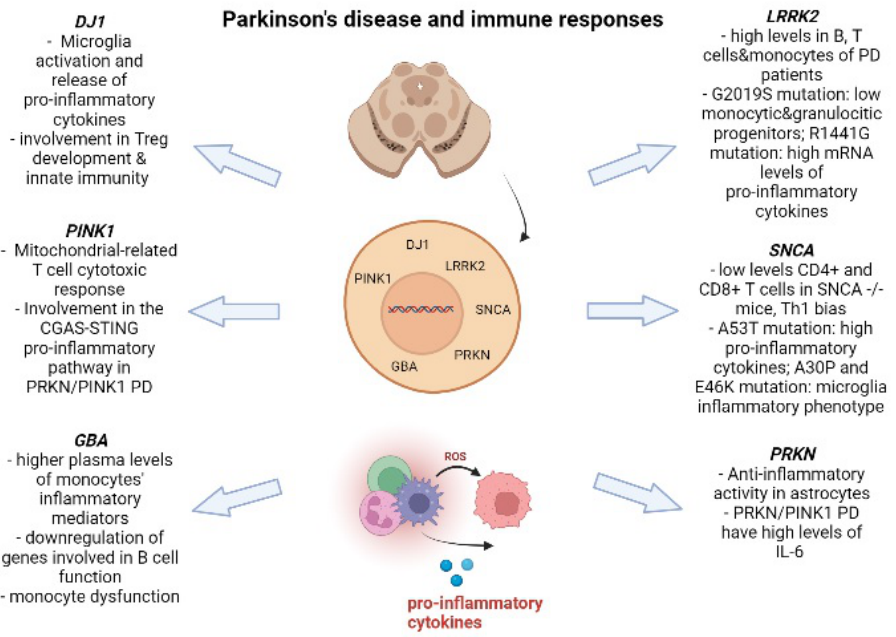
Figure 1. Interactions between PD genetic mutations and immune system. Created with www.biorender.com